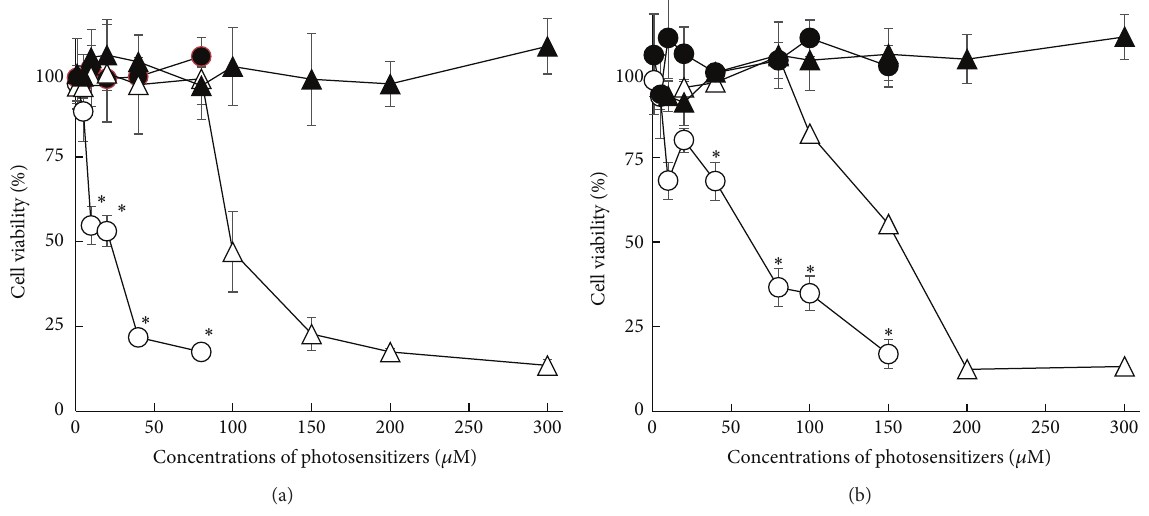
Figure 3: Photodynamic activities of C 60 /HP- 𝛽 -CyD nanoparticles and ALA for HeLa cells (a) and A549 cells (b) after visible light irradiation at 35 mW/cm 2 . Black filled circle: C 60 /HP- 𝛽 -CyD in the dark; black filled triangle: ALA in the dark; empty circle: C 60 /HP- 𝛽 -CyD with light irradiation; empty triangle: ALA with light irradiation. Each value points the mean ± S.E. of 3–5 experiments. ∗ 𝑃 < 0.05 versus ALA with light irradiation.